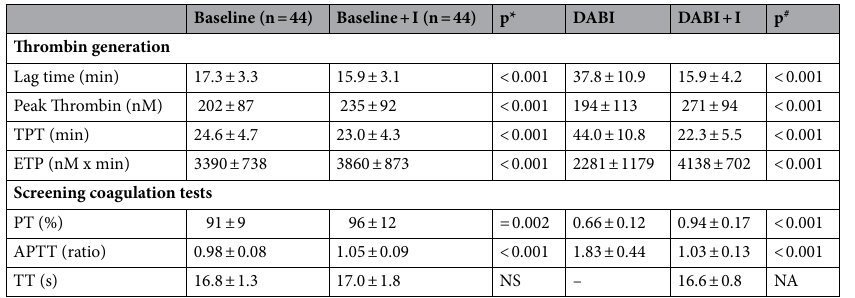
Table 1. TGA and screening coagulation tests before and after the addition of idarucizumab to either plasma without (baseline and baseline + I) or with dabigatran. Average ± SD and paired t-test p values are shown. APTT Activated Partial Thromboplastin Time, ETP Endogenous Thrombin Potential, I idarucizumab, NS not significant, PT Prothrombin Time, TGA Thrombin Generation Assay, TPT Time to Peak Thrombin. *Paired t-test between baseline and baseline + I. # Paired t-test between DABI and DABI +